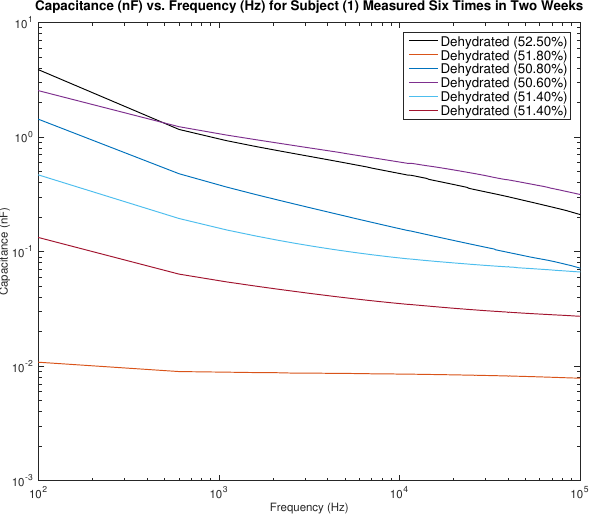
Figure 14. Testing results—capacitance (nF) vs. frequency (Hz) for subject 1 measured six times in two weeks on the right